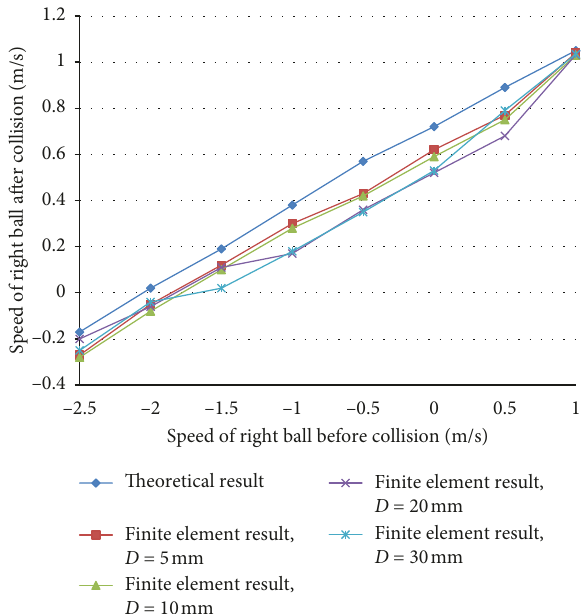
Figure 7: Relationship between the after-collision and before- collision speed of the right ball.